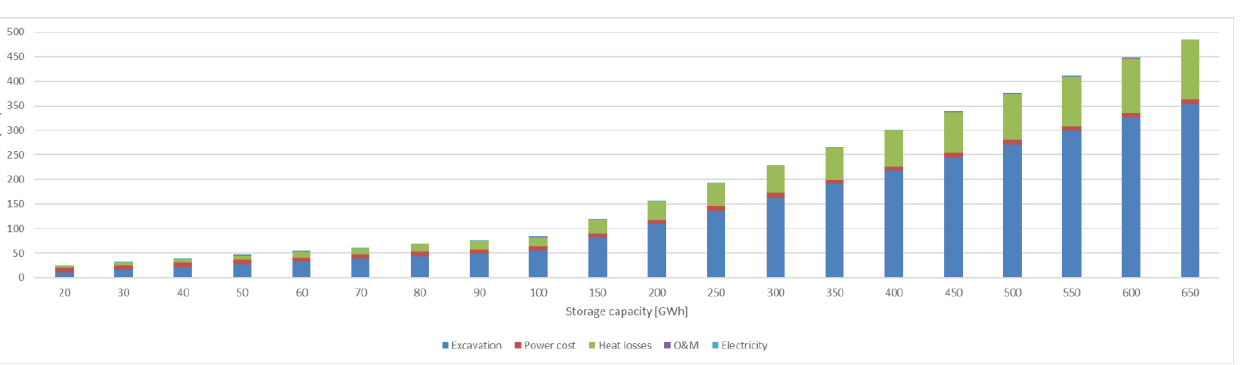
8 of 15 Figure 3. Return on investment of seasonal storages with 200 MW power.